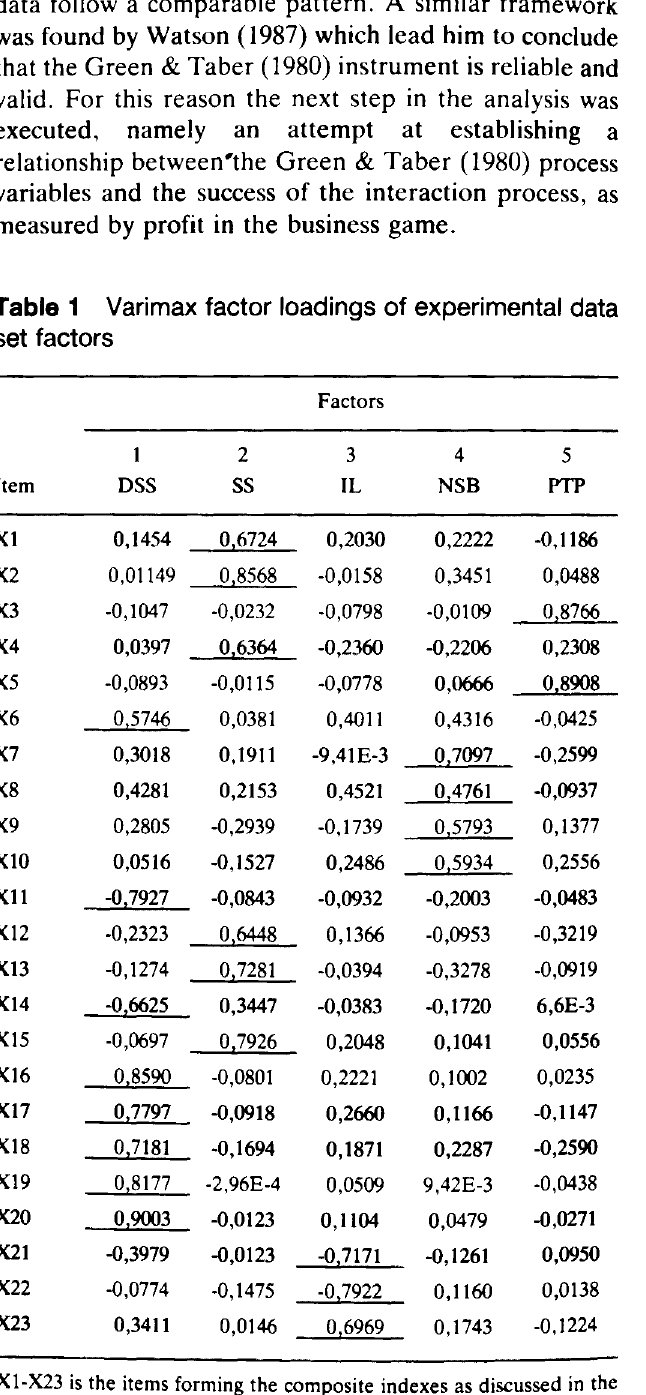
Table 1 Varimax factor loadings of experimental